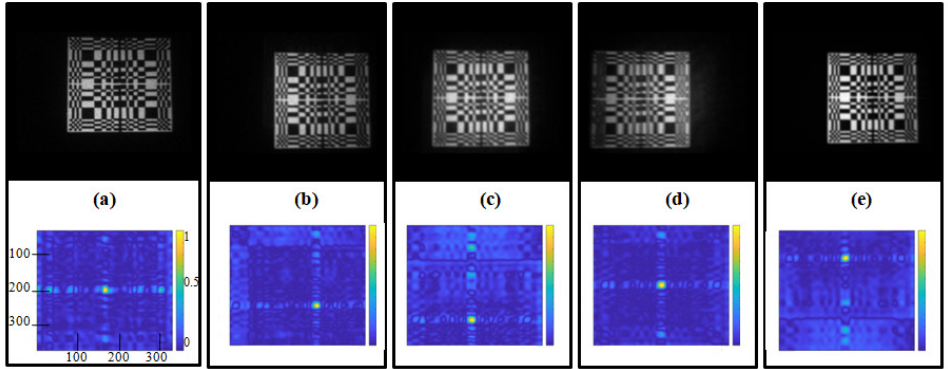
Figure 3. Five measured (up) images and decoded (down) experimental images: ( a ) PSF, ( b ) location 8, ( c ) location 17, ( d ) location 19 and ( e ) location 21. The same scale and legend remains valid for other subplots, as given in ( a ).